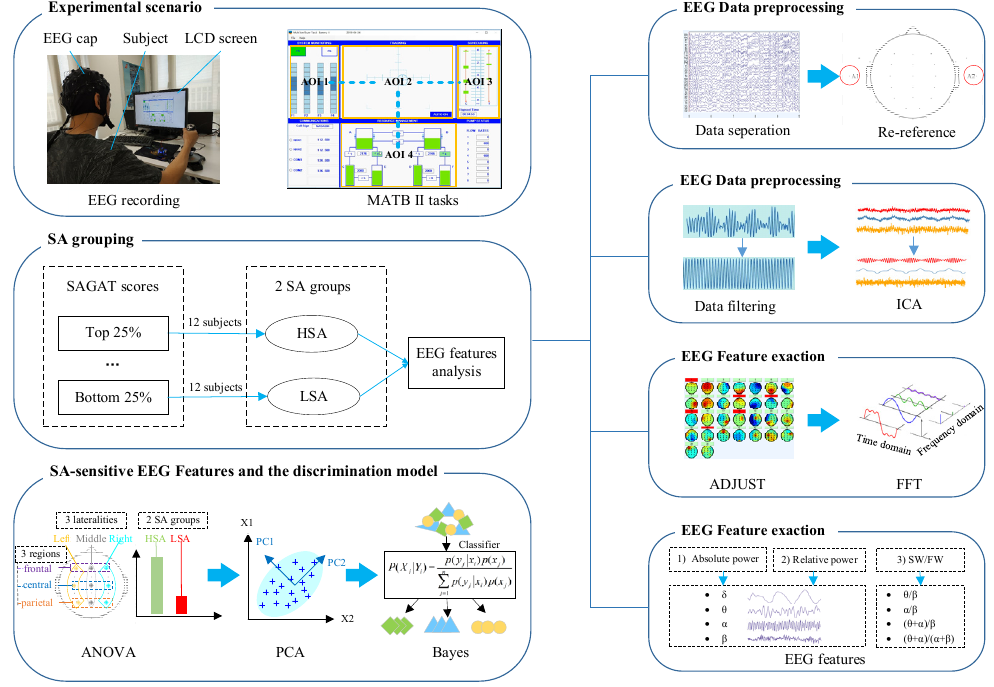
Figure 1. Overview of experimental procedures and data analysis methods.